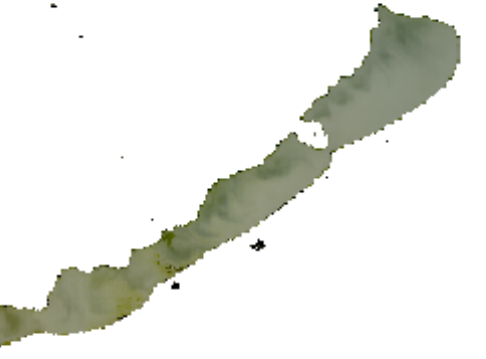
Figure 8. The RGB image of Lake Balaton at the 22 May 2017.